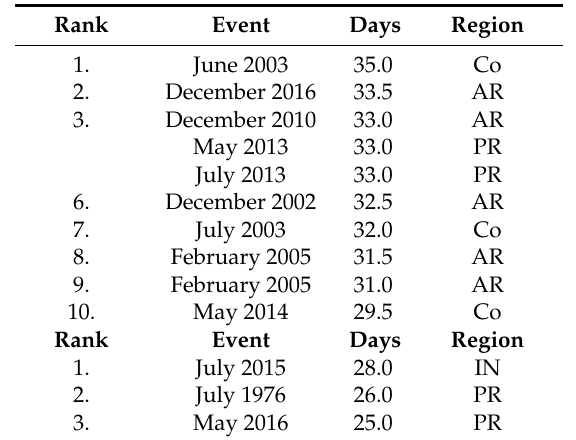
Table A5. The top 10 longest lived blocking events in the Northern Hemisphere (top) and Southern Hemisphere (bottom) from 1968 to the